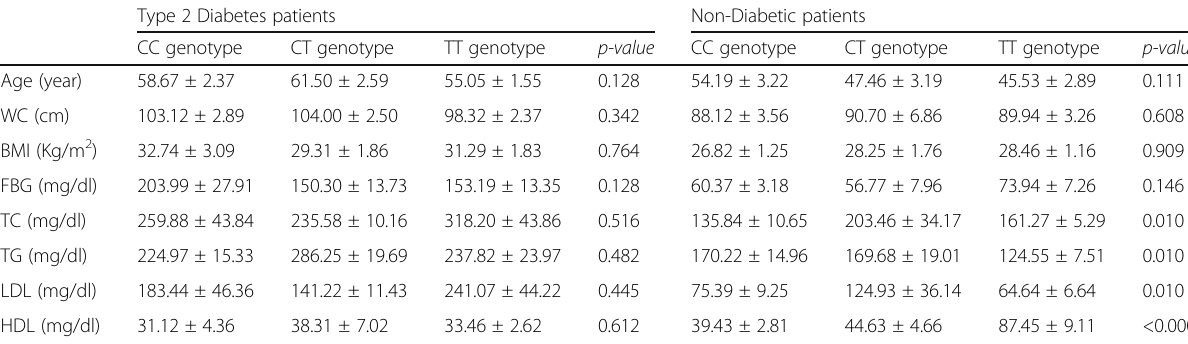
Table 4 Comparison of ABCC8 (C/T) polymorphism with demographic and clinical characteristics among T2D and ND